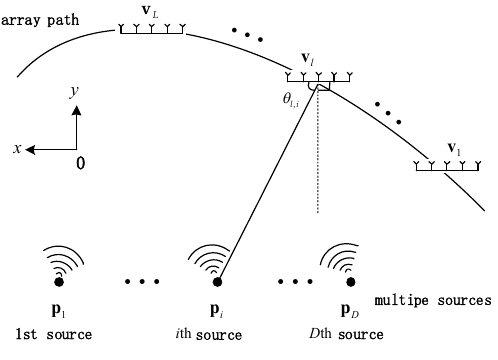
Figure 1. Geometry of one moving antenna array and multiple transmitters.